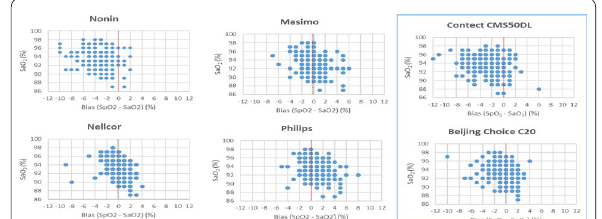
Figure: SpO2 gap from SaO2 at different SaO2 values for high-cost Nonin, Nellcor, Masimo, Philips oximeters and low-cost oximeters Contect CMS50DL and Beijing Choice